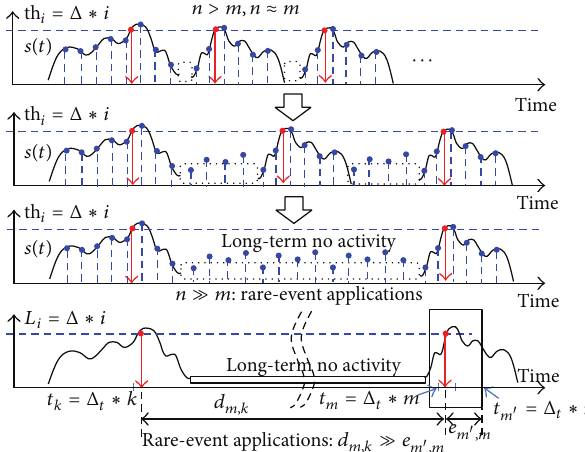
Figure 4: Wake-up frequency for data sampling and event-driven